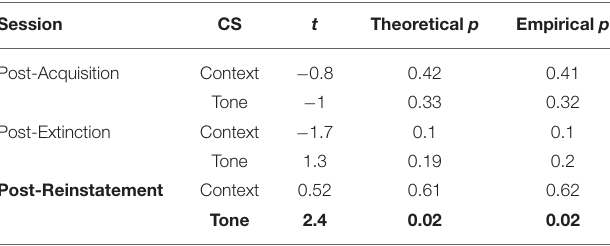
TABLE 5 | Simple effects of group differences in freezing to context vs. CS for each memory